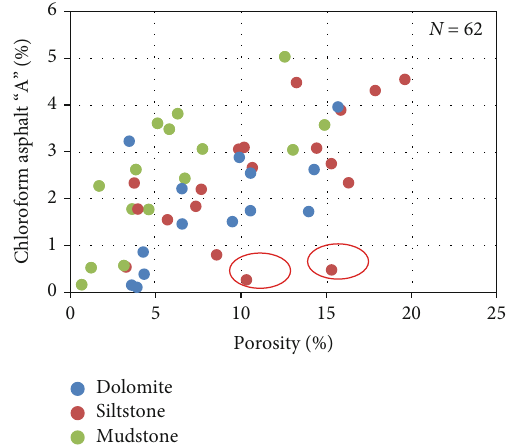
Figure 16: Relation diagram of chloroform asphalt “ A ” and porosity of rock samples from Lucaogou